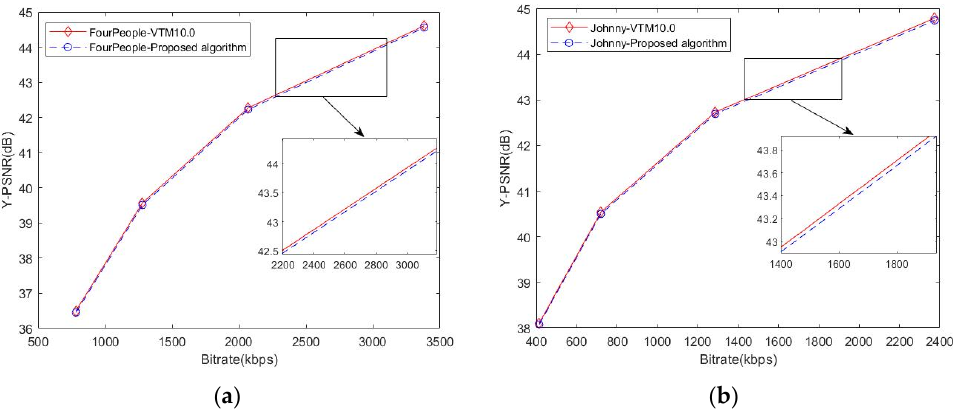
Figure 9. The time consumption percentage of the proposed algorithm.